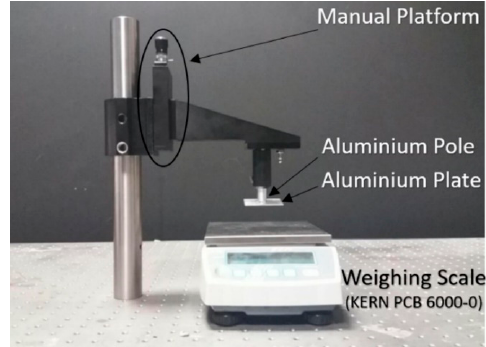
Figure 3. Set up for loading pressure.